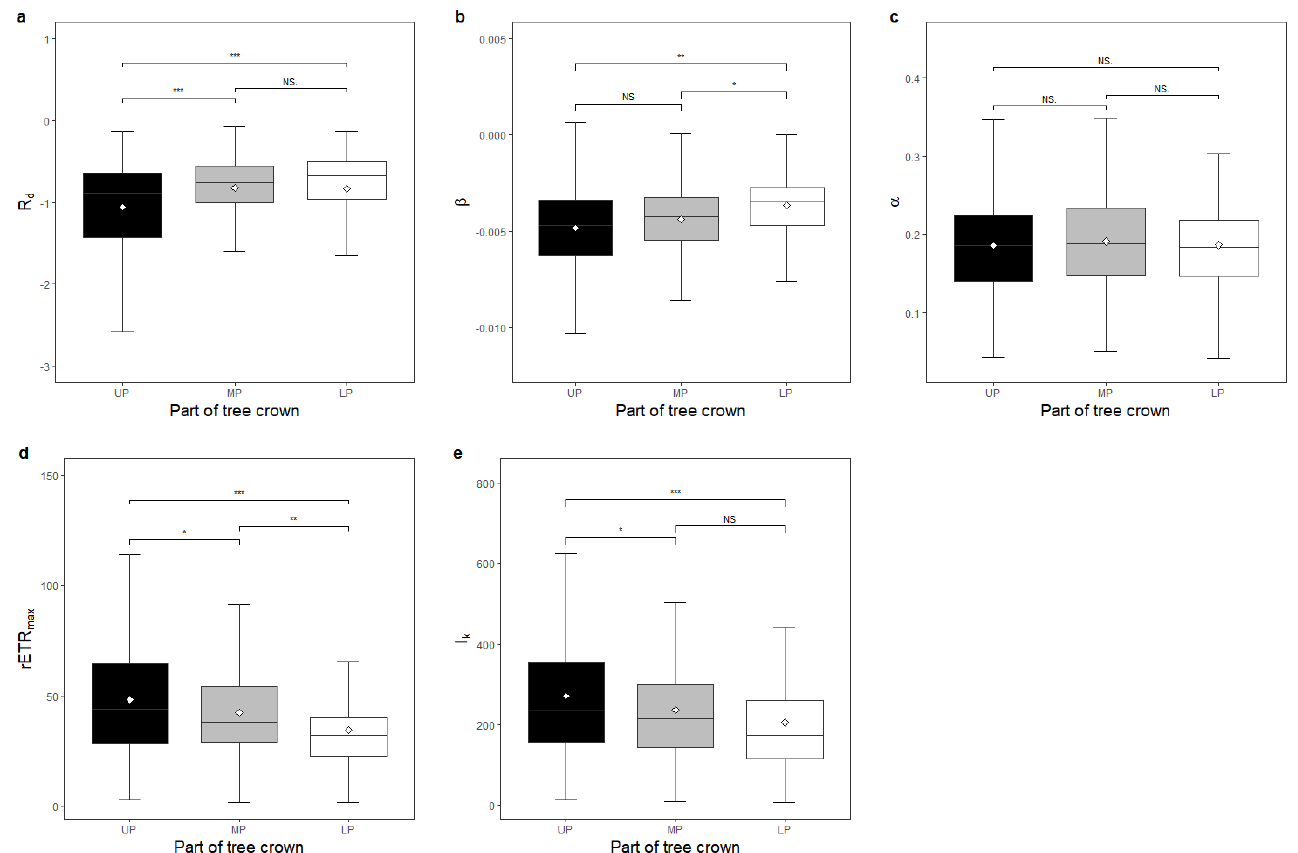
Figure 5. Differences in functional traits among different parts of the tree crown. Differences in each functional trait were checked using a Tukey test at a 95% family − wise confidence level. LP represents the lower part of tree crown; MP represents the middle part of tree crown; UP represents the upper part of tree crown. Black box represents UP, grey box represents MP and white box represents LP in each subfigure. R d : the rate of leaf dark respiration; β : photoinhibition coefficient of relative electron transport rate versus photosynthetic photon flux density curve (RLCs); α : initial slope of RLCs; rETR max : maximum relative electron transport rate; I k : half saturating irradiance. *** p < 0.001; ** p < 0.01; * p < 0.05; NS for not significant difference.